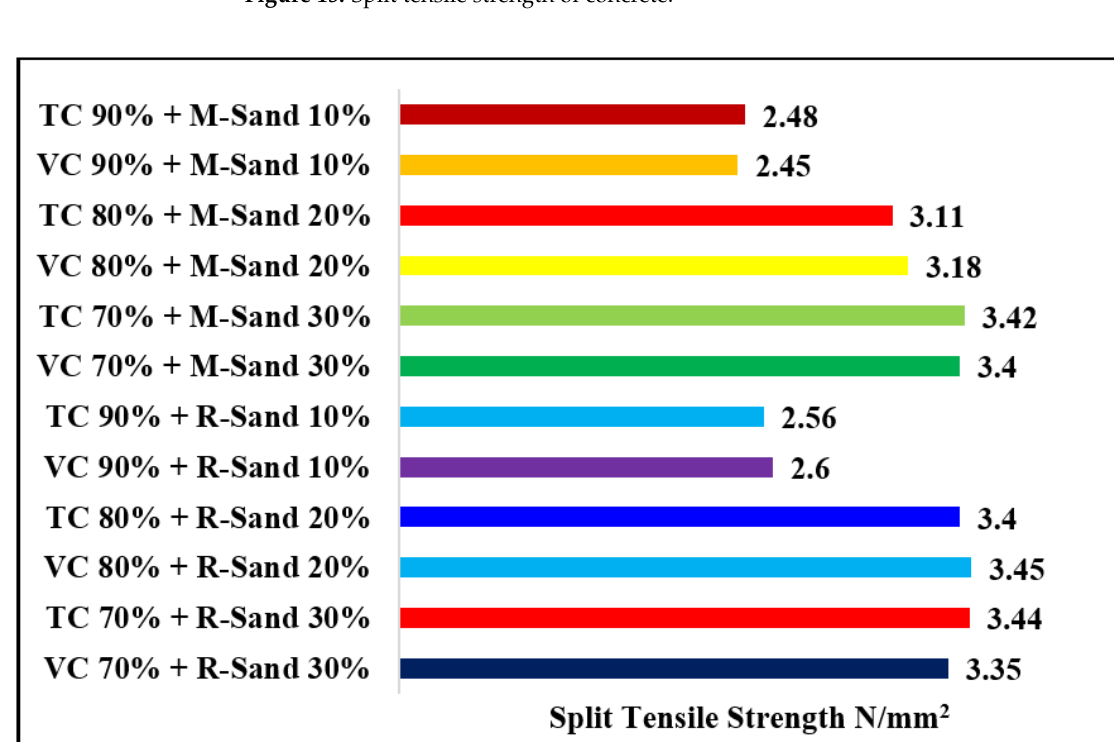
Figure 15. Split tensile strength of concrete.